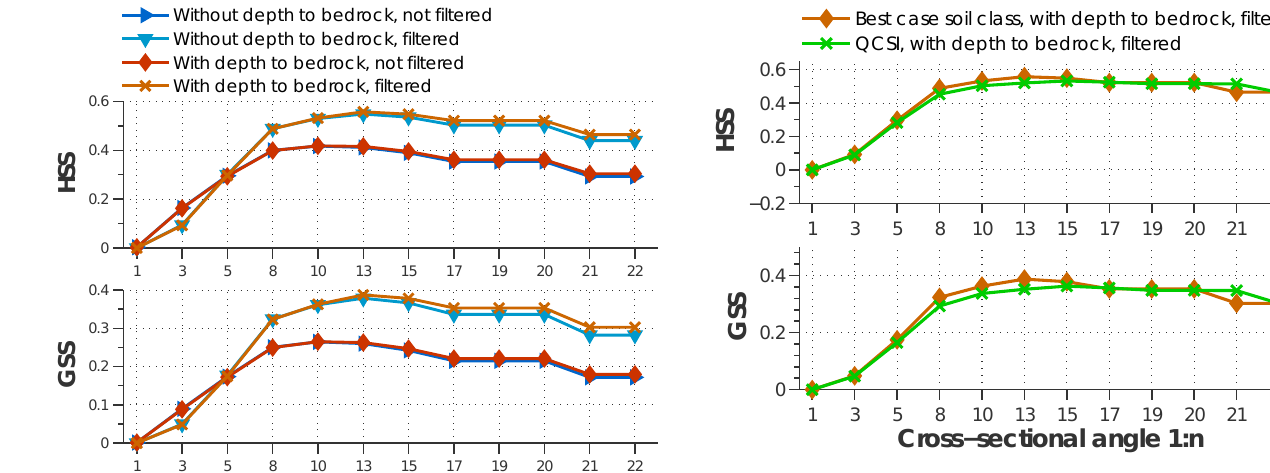
Figure 10. Heidke skill score and Gilbert skill score of the areas prone to landslides obtained with cross-sectional angle thresholds either held constant for the best-case soil class or dependent on the QCSI value. All the maps were obtained using the depth to bedrock data and were filtered. The effect of using QCSI-dependent cross- sectional angle thresholds is shown for several values of the cross- sectional angle threshold (i.e., from 1 : 1 to 1 : 22). Both skill scores show that the QCSI information is not improving the results, partic- ularly in the 1 : 8 to 1 : 13 cross-sectional angle